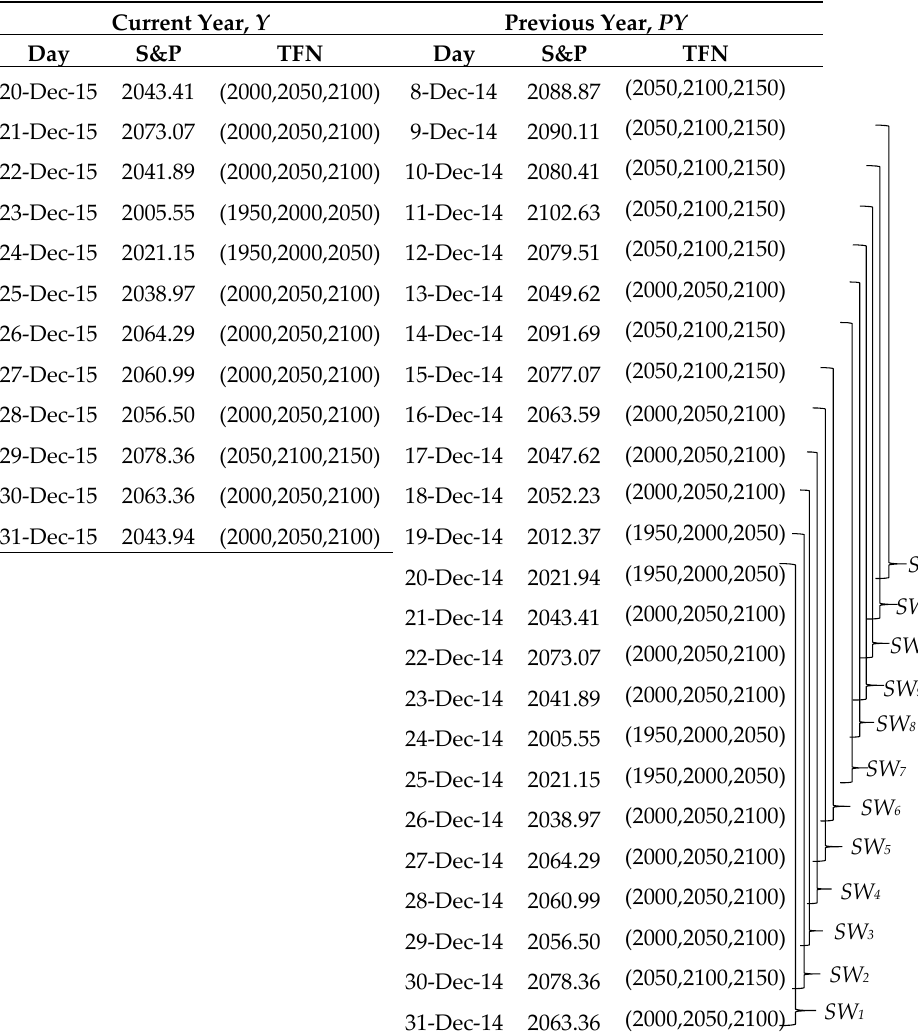
Figure 4. The triangular fuzzy numbers of the S&P dataset. Table 1. Matrix of the current year, Y and the previous year of S&P data, PY .